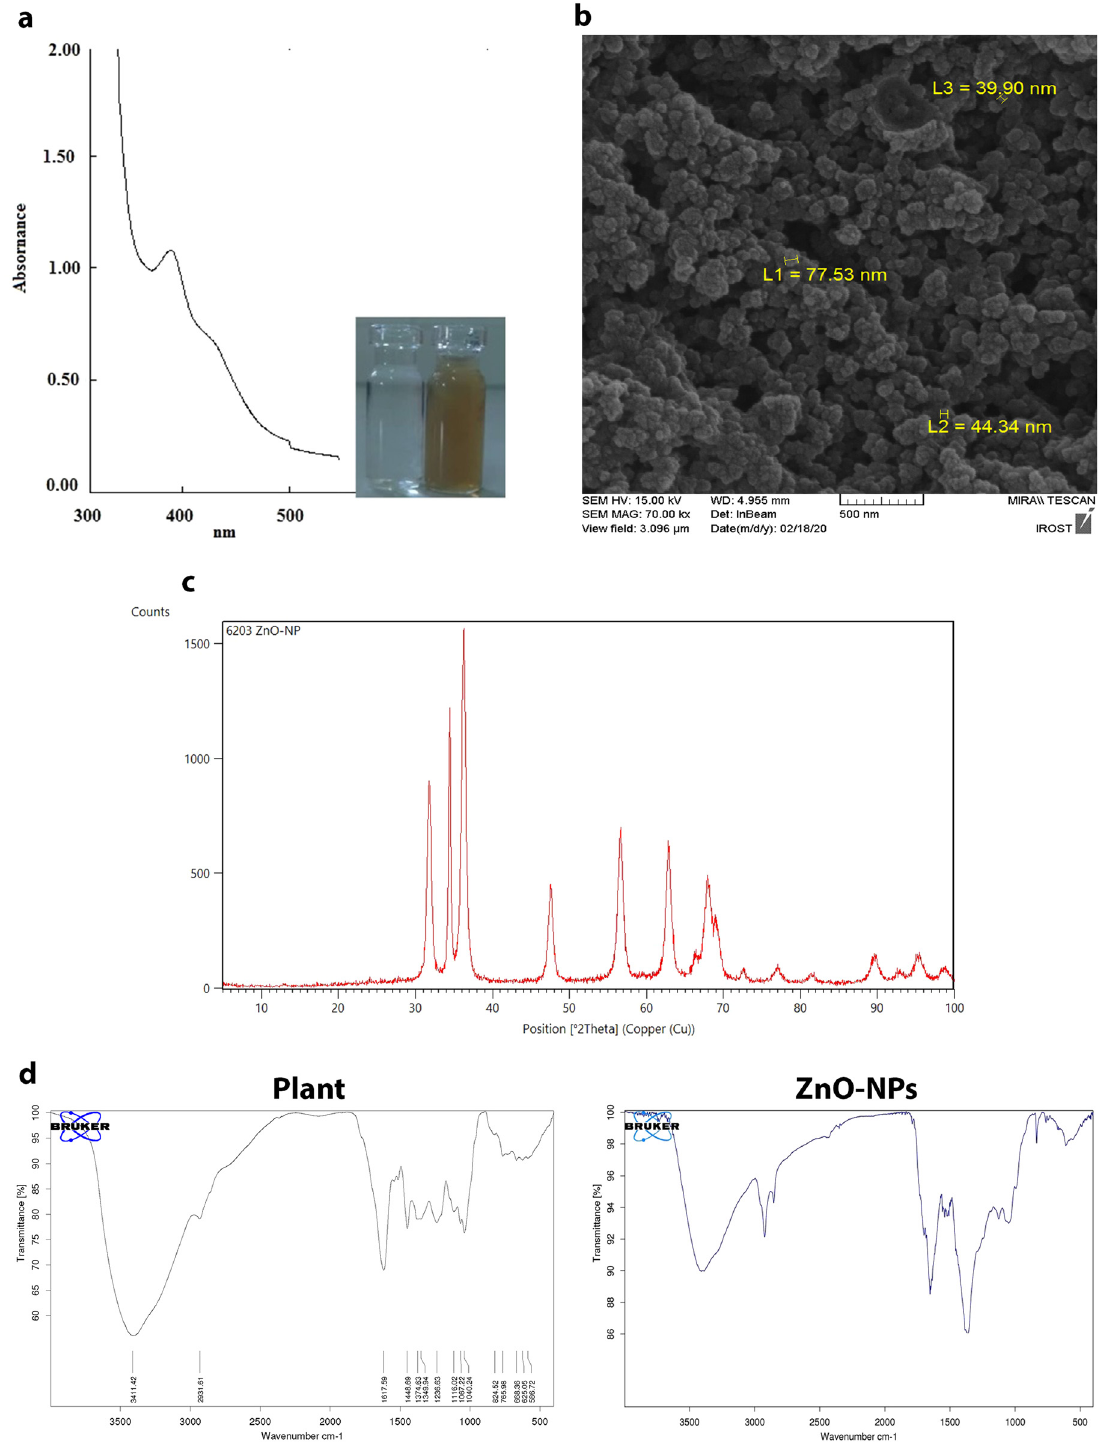
Figure 1: Characterization of green synthesized ZnO - NPs prepared using methanol extract of the A. serotinum plant. The UV - Vis spectrum of ZnO - NPs synthesized by A. serotinum and color change of zinc sulfate to ZnO - NPs ( a ) , FESEM image ( b ) , X - ray powder di ff raction pattern of the green synthesized ZnO - NPs ( c ) and FT - IR spectrum for plant extract and synthesized ZnO - NPs ( d )